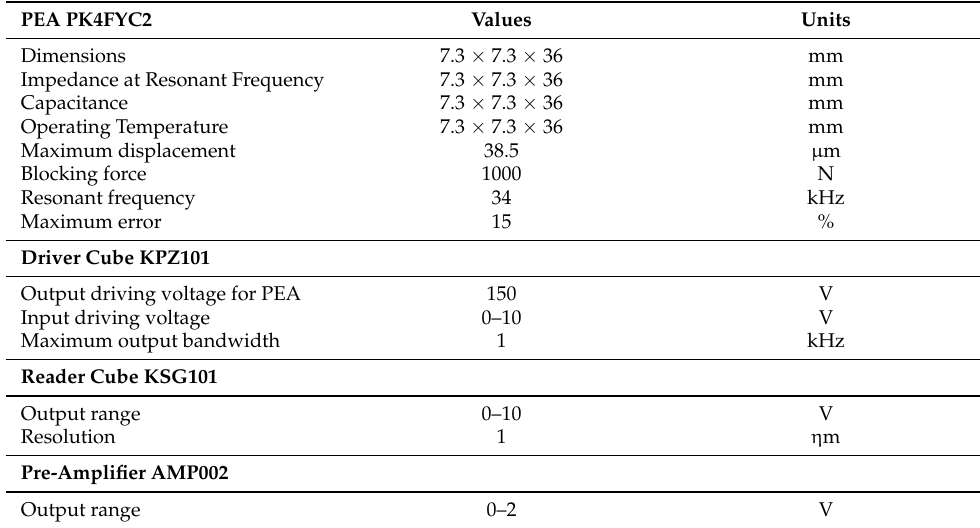
Table 1. Thorlabs hardware technical details.